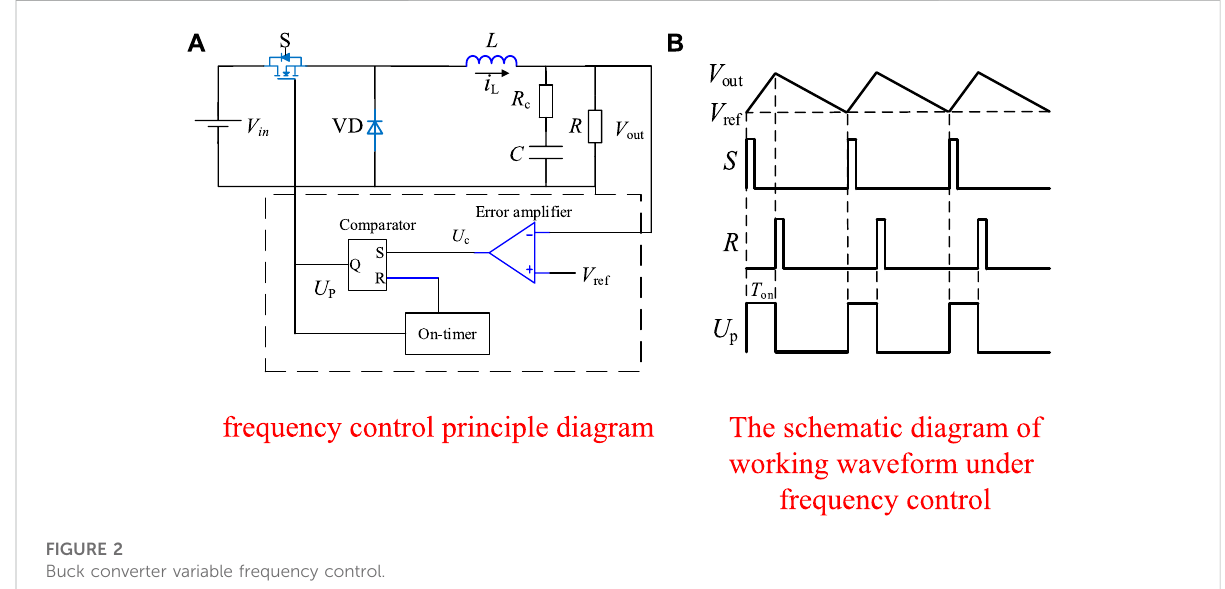
Buck converter variable frequency control.